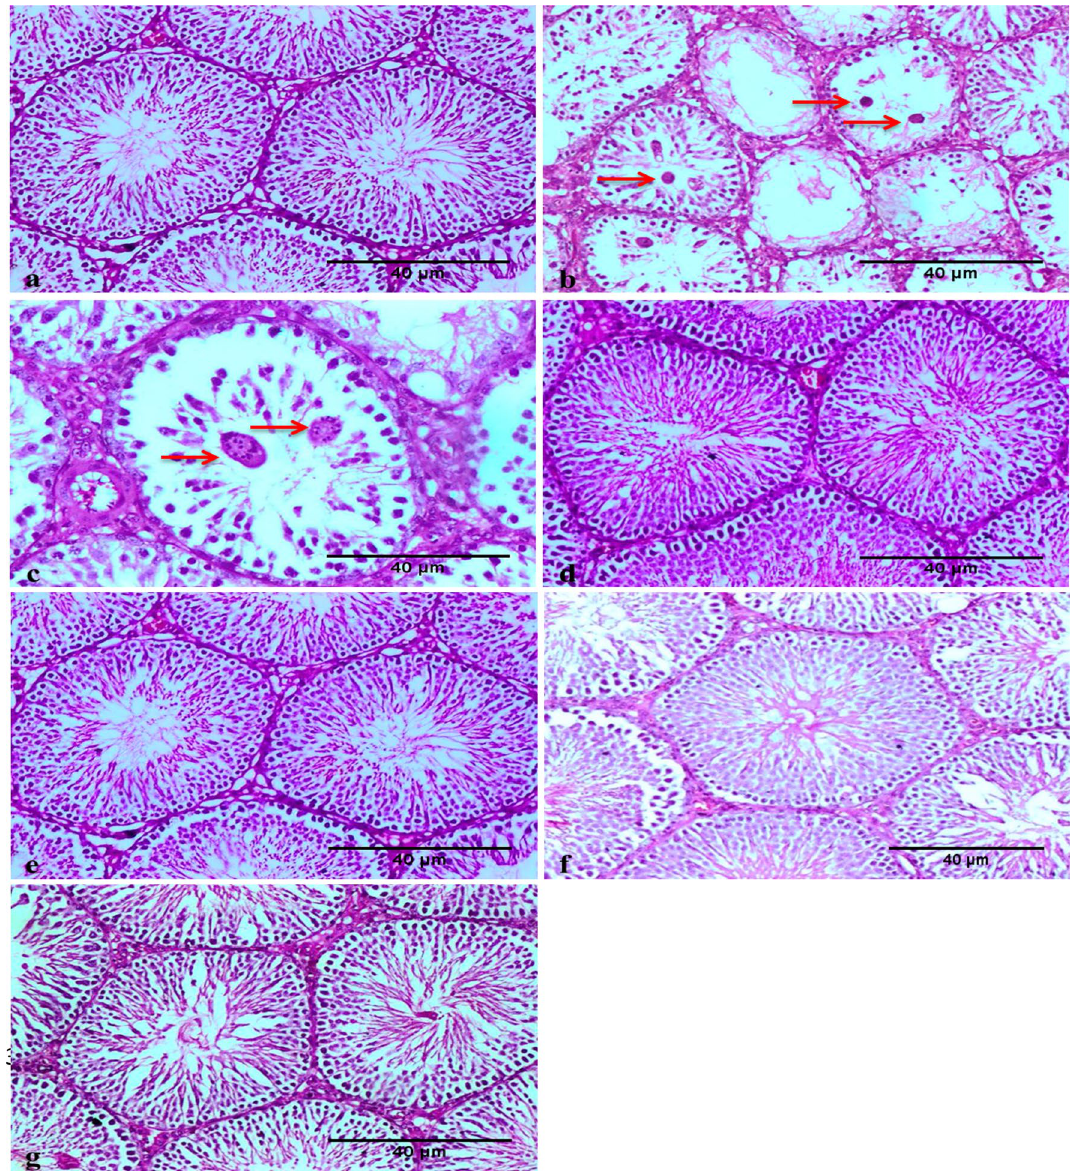
Figure 5. Photomicrograph showing the absence of histopathological changes in the testis of the control rat ( a ). The benzo[a]pyrene (B[a]P)-treated group shows severe desquamation, necrosis, and absence of spermatocytes and most Sertoli cells (Star) in the testis ( b ); these changes are associated with the formation of giant cells (symplast) (red arrows) ( c ) (H & E, 200 ×). The co-administration of zinc oxide nanoparticles (ZnO NPs) and B[a]P improved these histopathological alterations ( d and e ). Images showing a normal testis obtained from male rats treated with ZnO NPs (scale bar: 40 μm) ( f and g